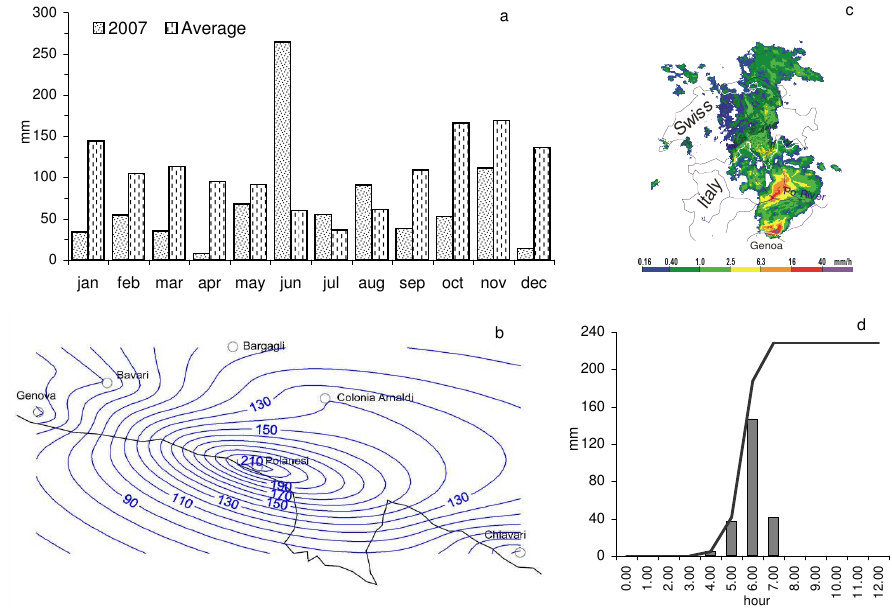
Fig. 3. Meteorological and climatic sketch: monthly rainfall distribution at Polanesi station (a) ; isohyeth map (mm) of 1 June 2007 event (b) ; Swiss radar image of pluviometric event (www.landi.ch/niederschlagsradar). (c) ; event hyetogram recorded at Polanesi station (d)